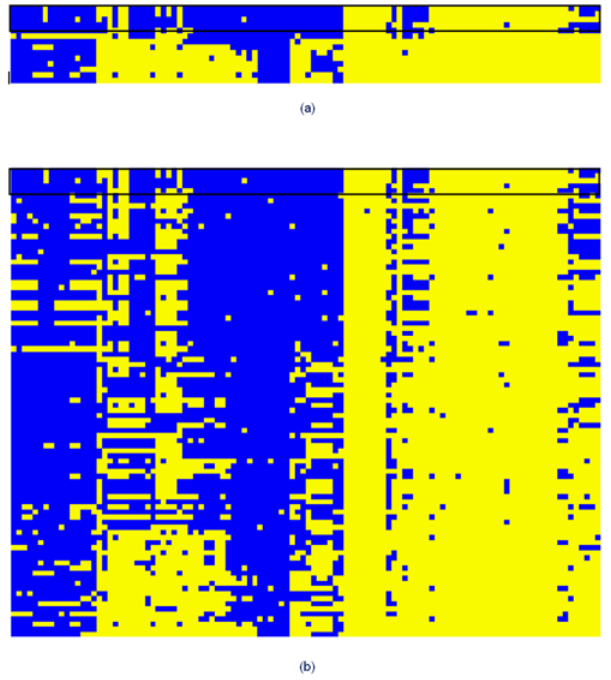
Figure 2. Phyletic patterns of COGs recovered in Psi-square searches (a) without pseudocounts and (b) with pseudocounts. In both, the same query COG01905 (the 24 kD subunit of NADH ubiquinone oxidoreductase complex) and the same parameters were used to search the target COG-06 database. The x axis represents genomes and the y axis represents COGs (See Table S7 for the detailed lists). The boxed part includes the patterns of five COGs in the initial DSSM.